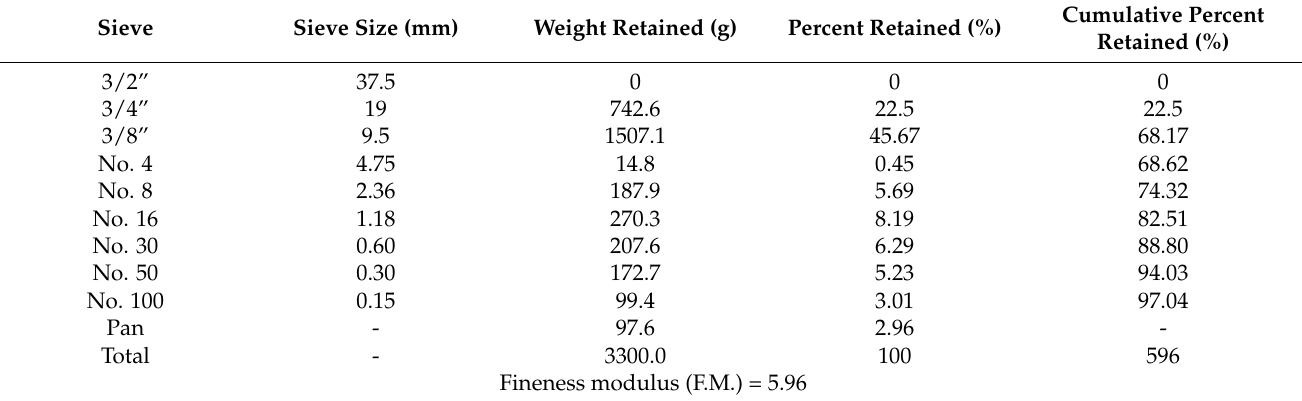
Table 3. Fineness moduli (FM) of fine and coarse